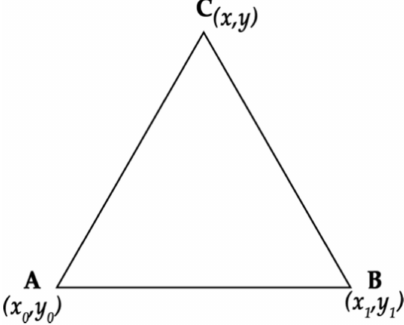
Figure 2. Triangle with a beacon located at each vertex.